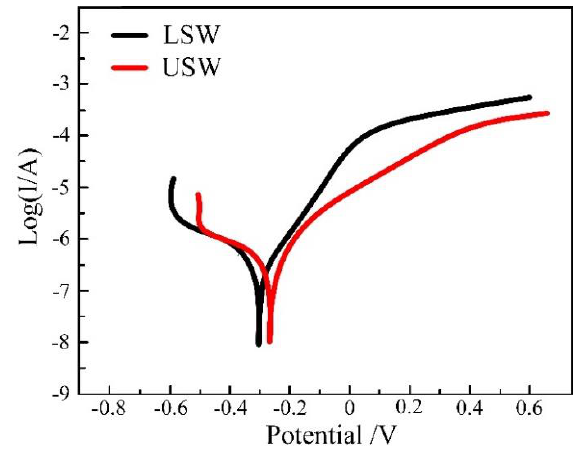
Figure 15. Polarization curve of weld. Table 4. Corrosion parameters of the longitudinal section and upper surface of the weld.